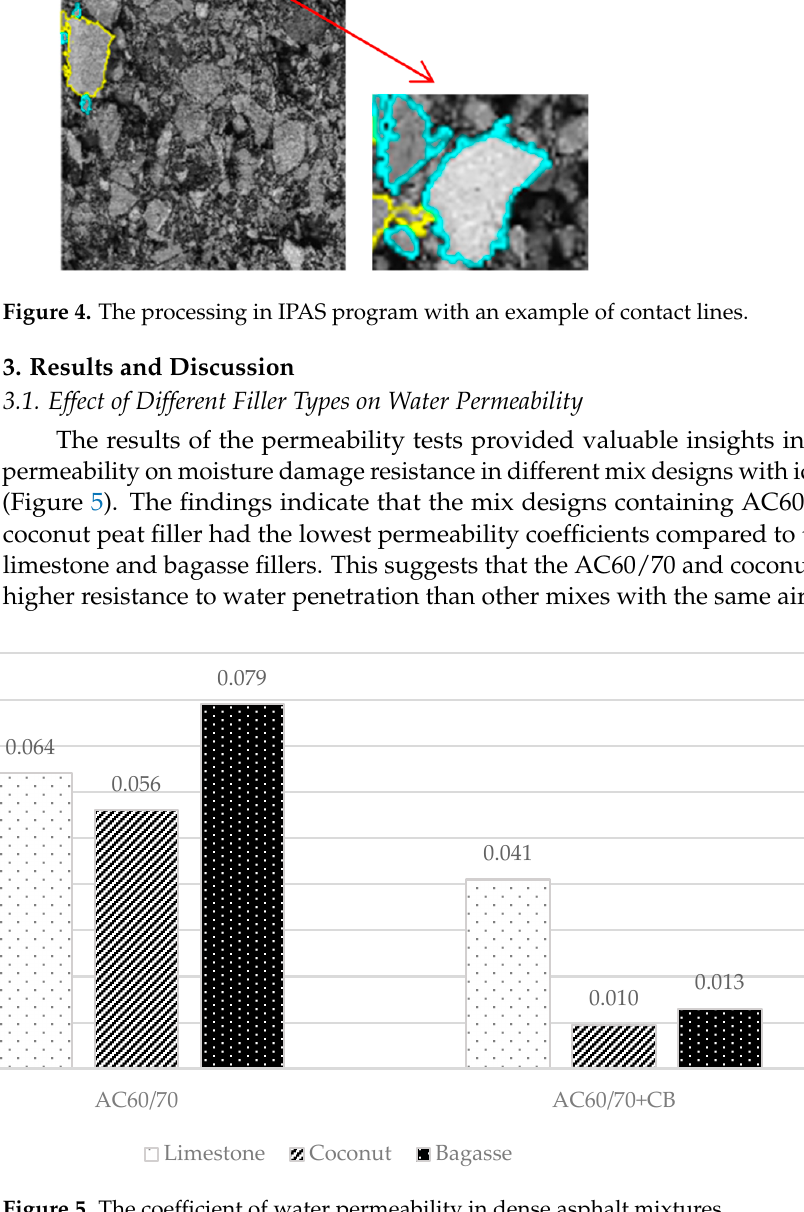
Figure 5. The coefficient of water permeability in dense asphalt mixtures.